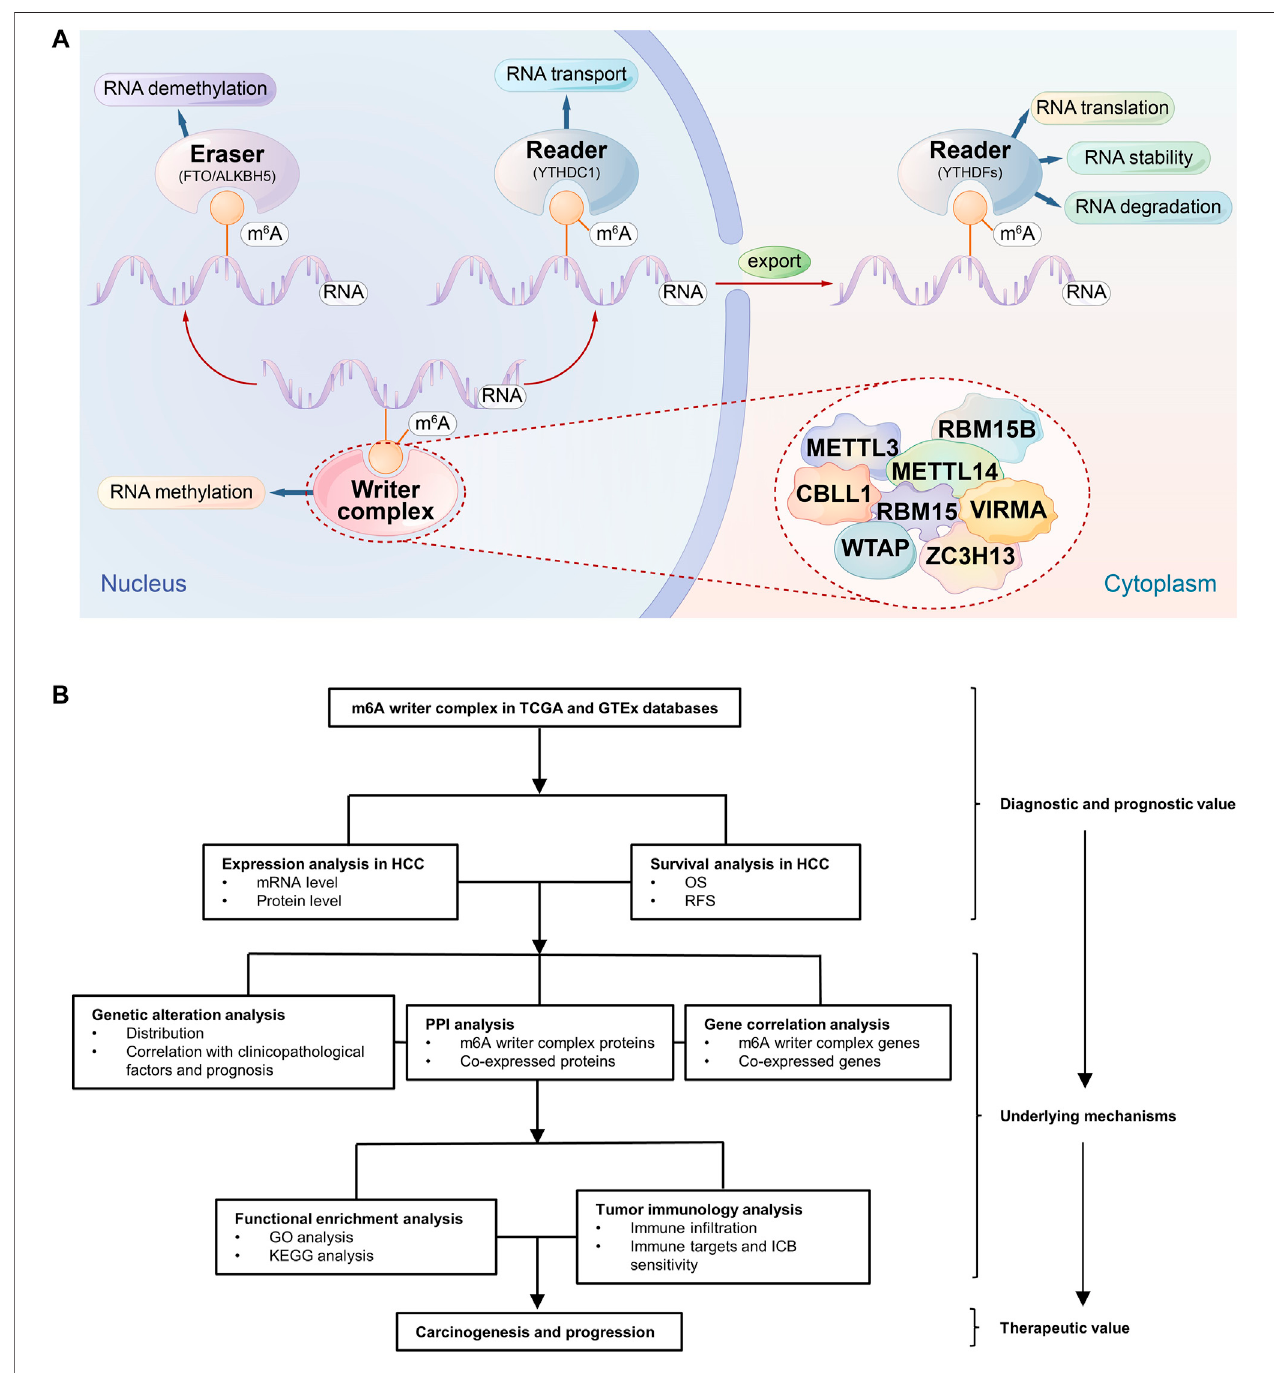
FIGURE 1 | Schematic diagram of the study. (A) The m 6 A mRNA life cycle. m 6 A methylation is a dynamic and reversible process involving methyltransferases (writers), removal by demethylases (erasers), and binding to speci fi c reader proteins that affect the stability, translation and degradation of mRNA. The m 6 A writer complex consists of METTL3, METTL14, WTAP, RBM15, METTL15B, VIRMA, ZC3H13, and CBLL1. (B) The fl owchart of the study.